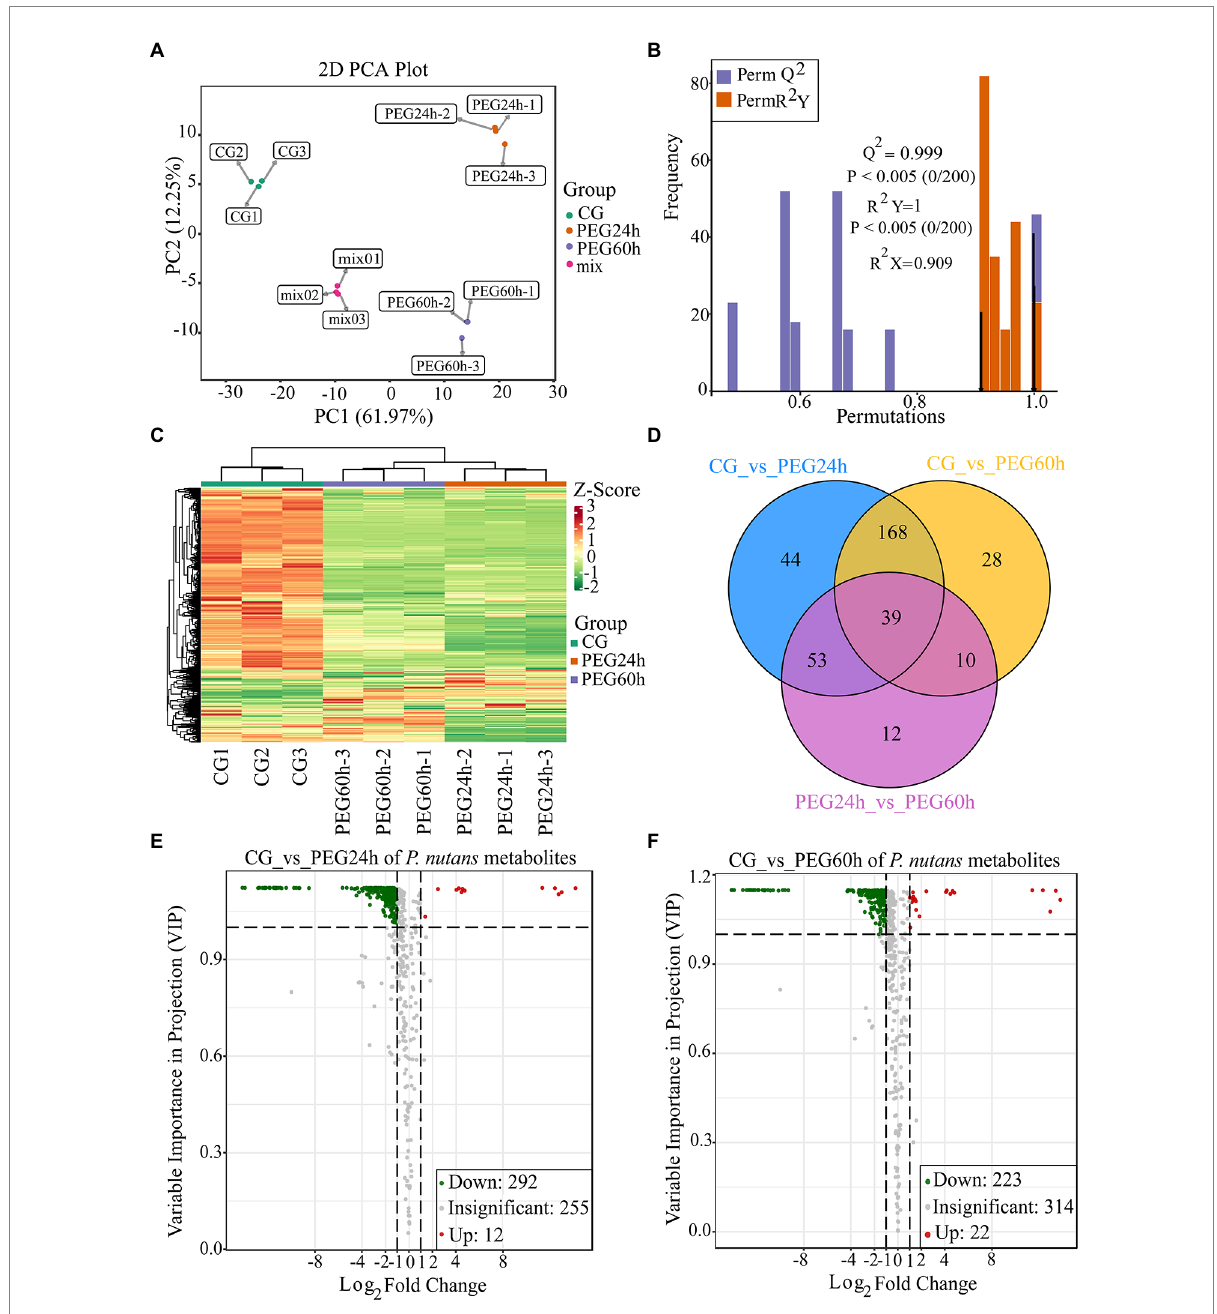
FIGURE 4 Widely targeted metabolome analysis of Pohlia nutans under drought stress. (A) Principal component analysis (PCA) for mass spectrum data under different groups. CG is control without PEG6000 treatment. Mix means the mixed samples. PEG is abbreviation of PEG6000. Here each group was replicated for three biologicals. (B) Orthogonal projections to latent structures discriminant analysis (OPLS-DA) for mass spectrum data. (C) Differentially changed metabolites (DCMs) clustering heatmap. Horizontal ordinate shows the sample name, and vertical ordinate is the DCMs. After hierarchical clustering of DCMs, the dendritic plot to the left of the heat map represents the results of DCMs clustering. (D) The Venn diagram showing the shared and unique DCMs in three different groups. (E) Volcano plot showing the DCMs in the PEG24 h vs. CG. (F) Volcano plot showing the DCMs in the PEG60 h vs. CG. Each dot represents one metabolite. The horizontal ordinate indicates the fold change of the metabolites between the two groups, and the VIP value indicates significant differences in the statistical